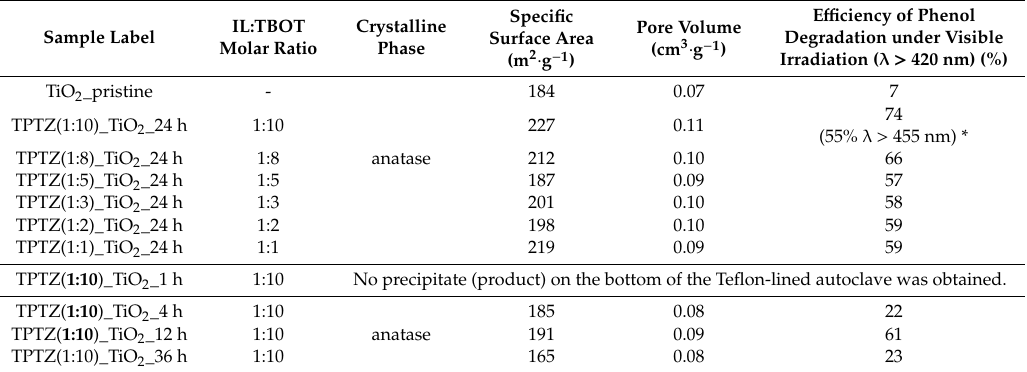
Table 1. Characterization and photocatalytic activity of the samples TPTZ_TiO 2